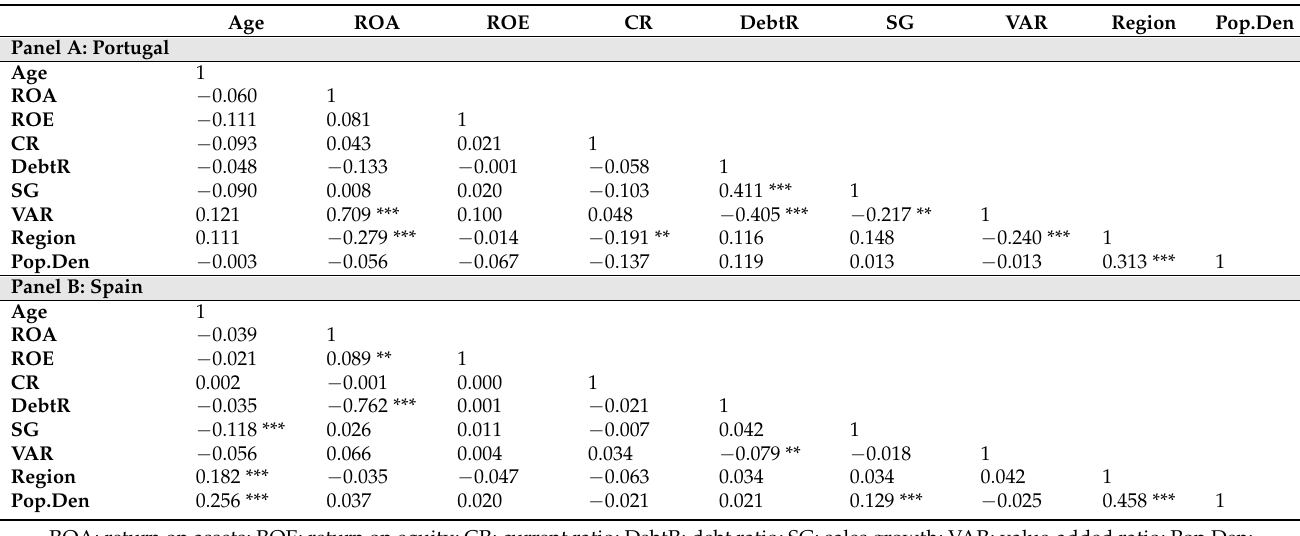
Table 5. Correlation